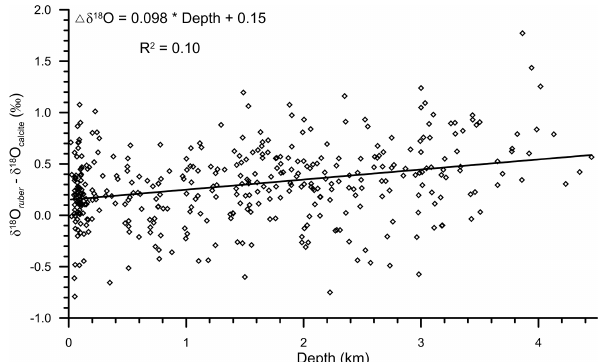
Figure 12. The relationship of the difference between measured δ 18 O ruber and expected δ 18 O calcite with the water depth from which the surface samples were collected in the northern Indian Ocean. The δ 18 O ruber − δ 18 O calcite increased with increasing water depth.